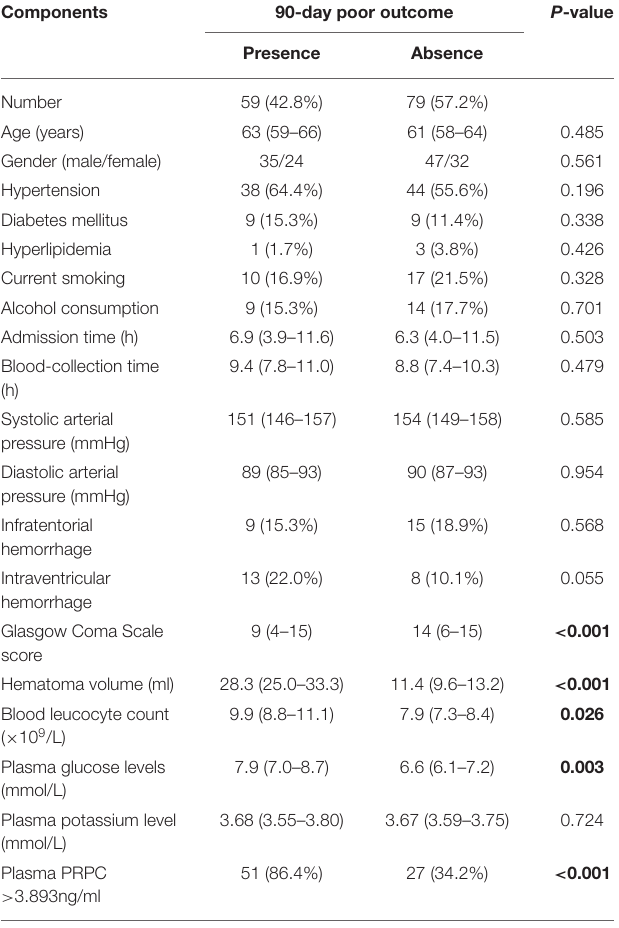
TABLE 5 | Demographic, clinical, radiological and biochemical factors for 90-day poor outcome after acute intracerebral hemorrhage. Components